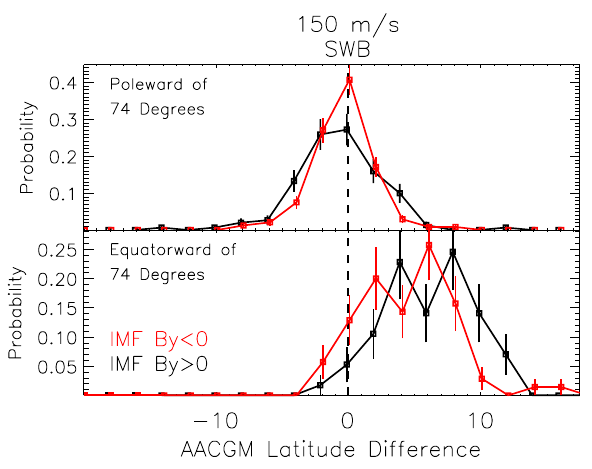
Fig. 7. Probability distributions of latitude differences between the DMSP doc boundary and the 150m/s threshold SWB for the com- bined Goose Bay and Finland SuperDARN radars in the 12:00– 18:00 MLT region. The upper panel represents the results from comparisons using SWBs located poleward of 74 ◦ , whereas the lower panel represents the results from comparisons using SWBs located equatorward of 74 ◦ . The black distributions represent the results measured during intervals of IMF B y > 0, whereas the red distributions represent the results measured during intervals of IMF B y <